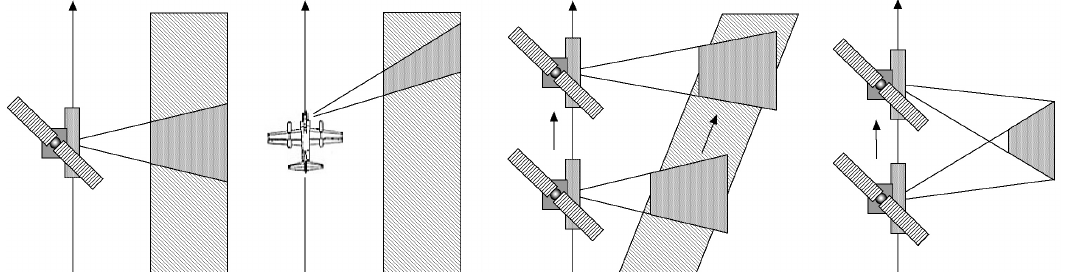
Figure 5. Different beam modes. From left to right: strip (map), squint strip (map), wide-swath scan, and spotlight